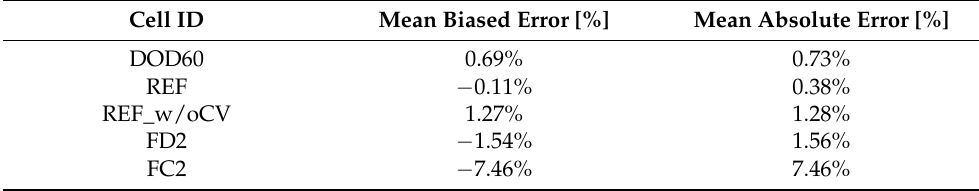
Table 4. Validation subset with results of MBE and MAE. Details about the testing protocols in Table